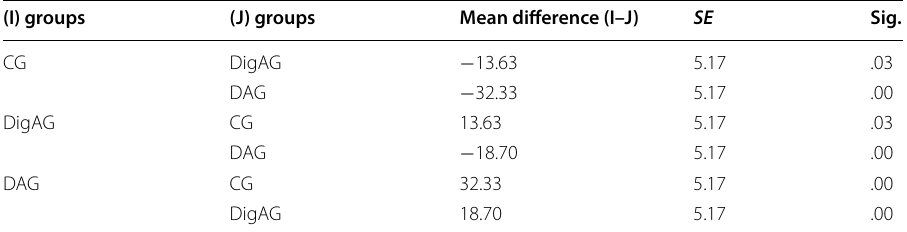
Table 20 Comparing anxiety posttest of all groups by using a Scheffe test (I) groups (J)